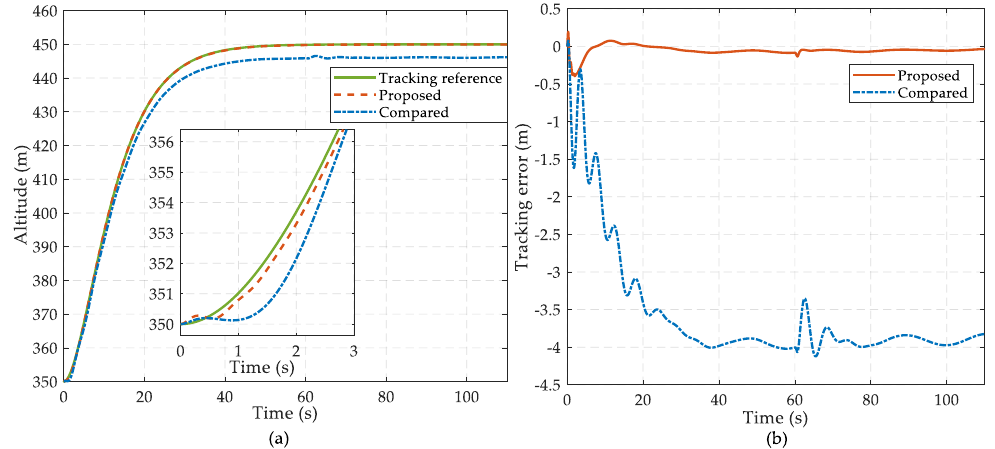
Figure 3. The saucer-shaped UAV altitude tracking performance: ( a ) Comparison of the response of altitude tracking and ( b ) comparison of the altitude tracking error. Appl. Sci. 2020 , 10 , x FOR PEER REVIEW